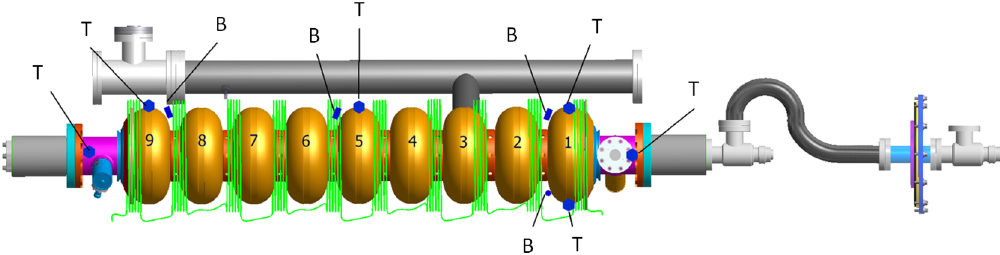
FIG. 8. Horizontal test set-up to measure a nitrogen doped cavity, indicating the location of the instrumentation (T for temperature sensors, B for fluxgate (magnetic) sensors). For determining the temperature difference along the cavity, the leftmost and rightmost sensor was used. The green contour represents a solenoid that was wound around the cavity which is of no relevance within this